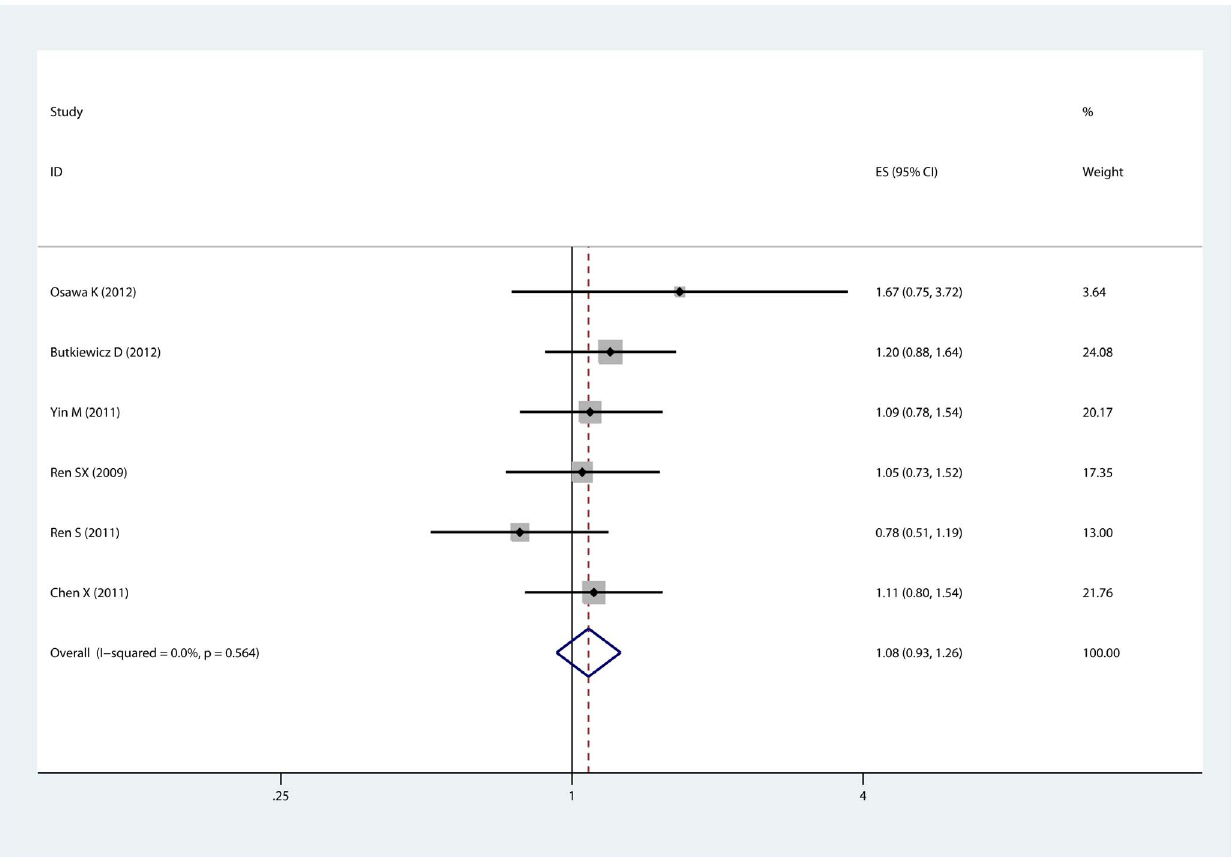
Figure 3. Forest plot of the comparison of ThrMet + MetMet vs. ThrThr for overall survival. HR=1.082, 95% CI: 0.929–1.261, p=0.564 for heterogeneity.